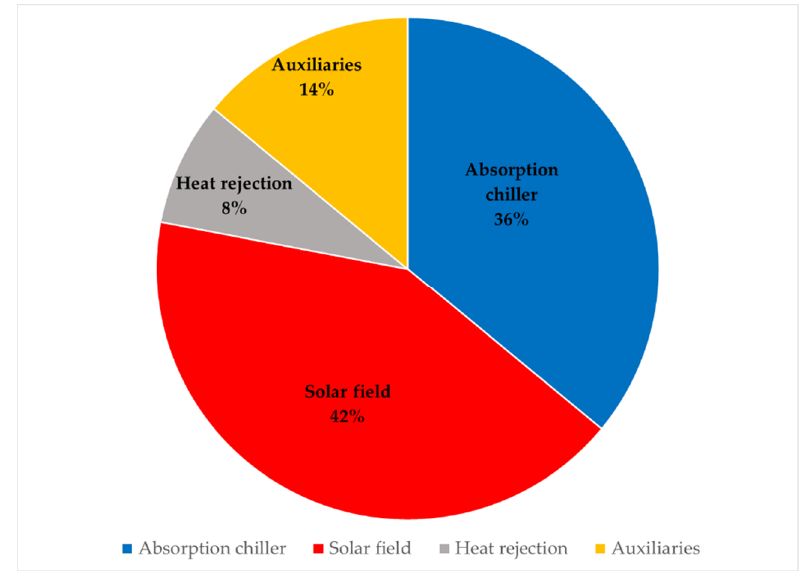
Figure 8. Share of absorption system components in the total cost.